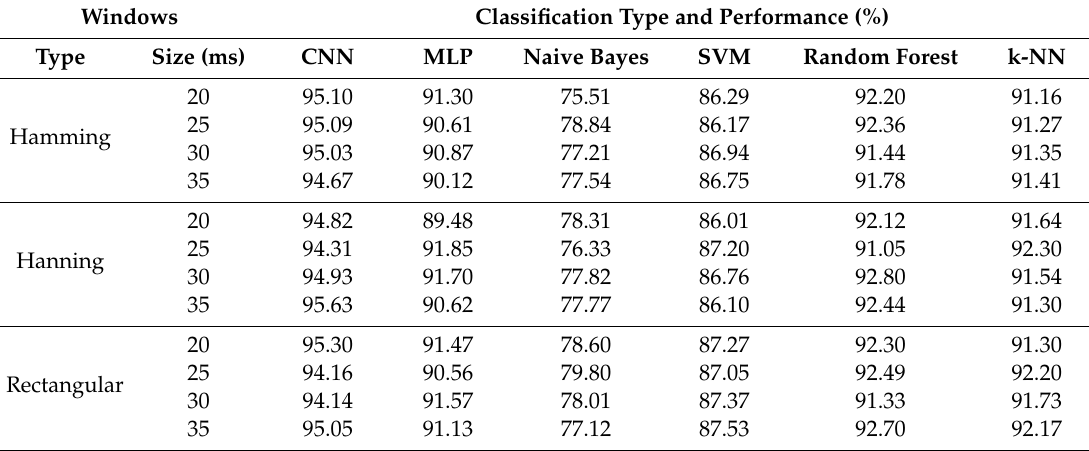
Table 9. Performance accuracy for female speakers based on GRU + EZDDMFCC.